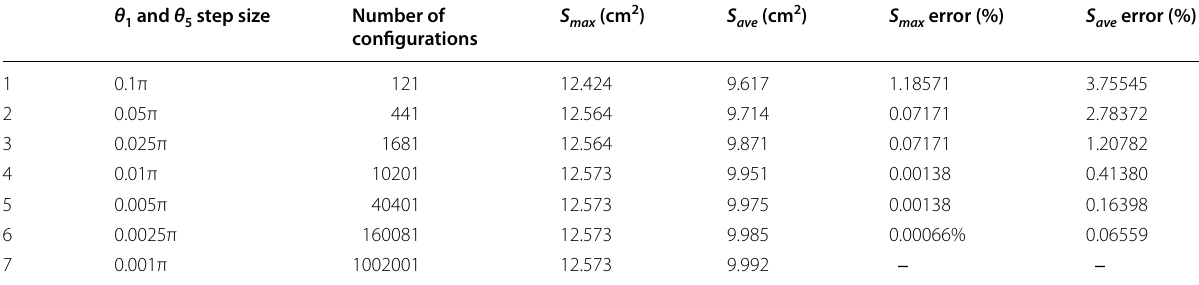
Table 2 Error in different design parameters θ 1 and θ 5 step size